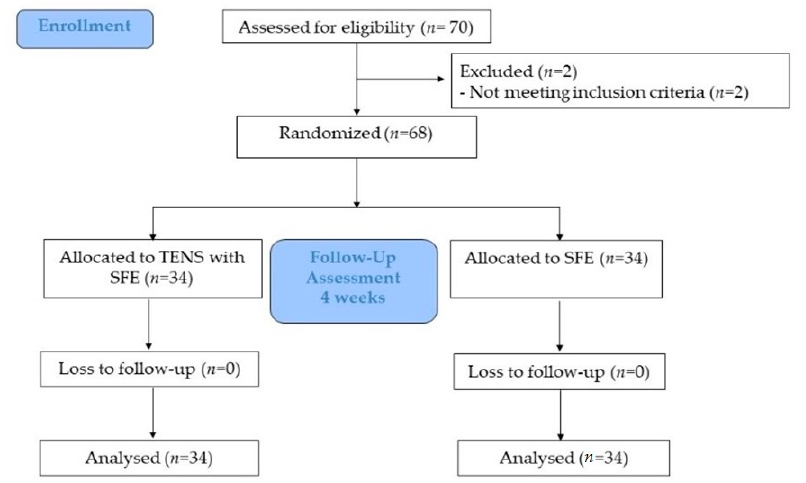
Figure 1. Flow chart of the participants. TENS, transcutaneous electrical nerve stimulation; SFE, short foot exercise.